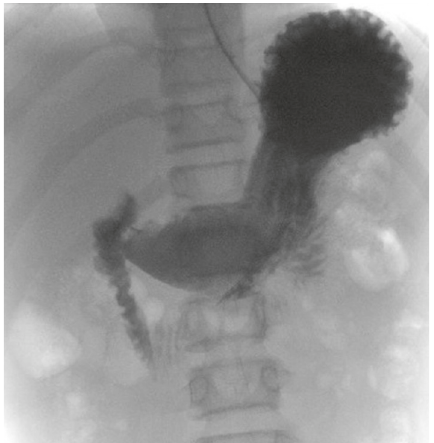
Figure 2: Upper GI study post-Coca-Cola ® infusion showing no filling defect in the stomach or small bowel to suggest